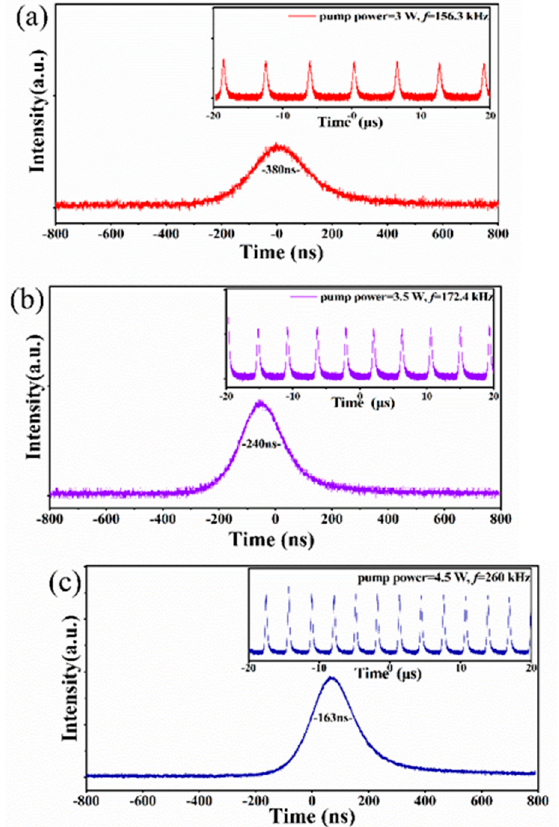
Figure 8. Single-pulse shape (Inset: temporal pulse trains) of the Q-switched lasers at the pump power of 3 W ( a ), 3.5 W ( b ), and 4.5 W ( c ). With a laser beam profiling system (BeamGate, Ophir-Spiricon, North Logan, UT, USA), the beam quality of the CW and PQS Nd:YAG laser was evaluated. Figure 9a shows the 2D and 3D spatial power distribution of CW Nd:YAG laser at the pump power of 3 W. Figure 9b–d show the 2D and 3D spatial power distribution of PQS Nd:YAG laser at the pump power of 3 W, 3.5 W, and 4.5 W. These results indicated that the output trans- verse modes of the CW and PQS Nd:YAG laser are all TEM 00 modes, which means the out laser beam have a high quality.